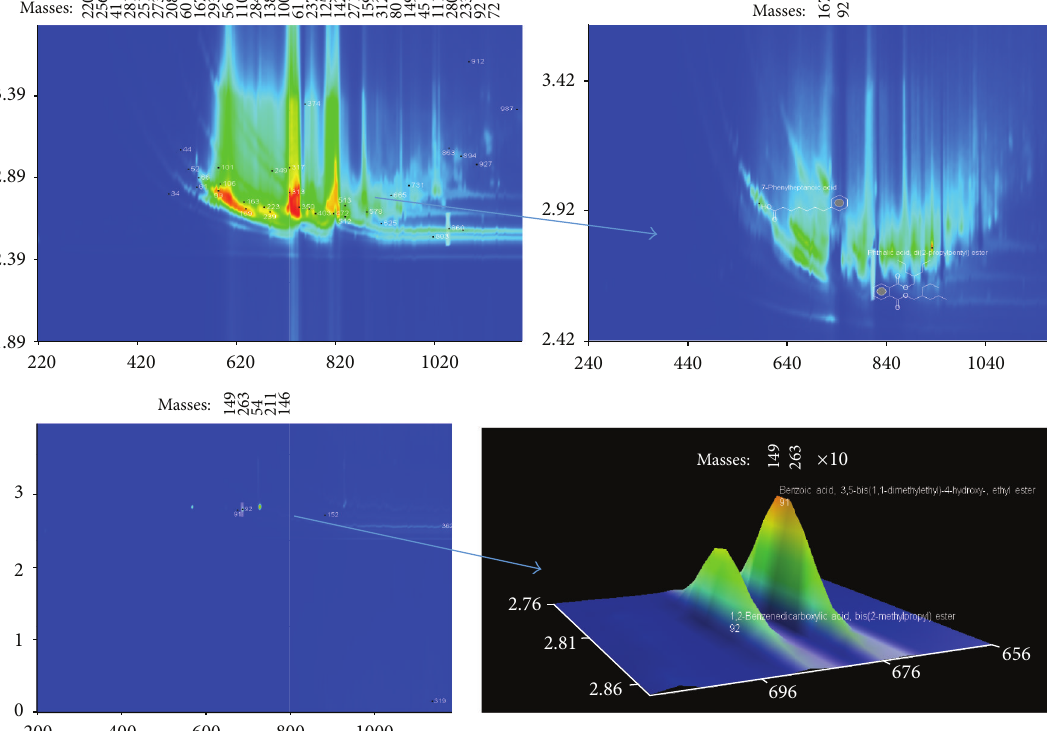
Figure 1: 2D chromatograms showing the compounds extracted in raw water using silica SPE and determined by using deconvolution ChromaTOF software in the GC × GC-TOFMS technique. Aromatic acids are shown in zoomed chromatograms to the right and indicated by arrows. The respective names, retention times, and GC-library similarities of selected carboxylic acids are tabulated (Table